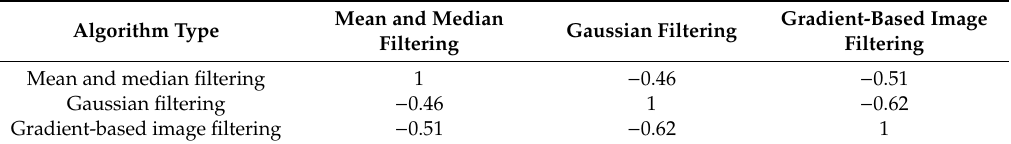
Table A9. The Pearson correlation coe ffi cients of the di ff erent edge smoothing algorithms using FID. It confirms that our sample accuracy was independent.